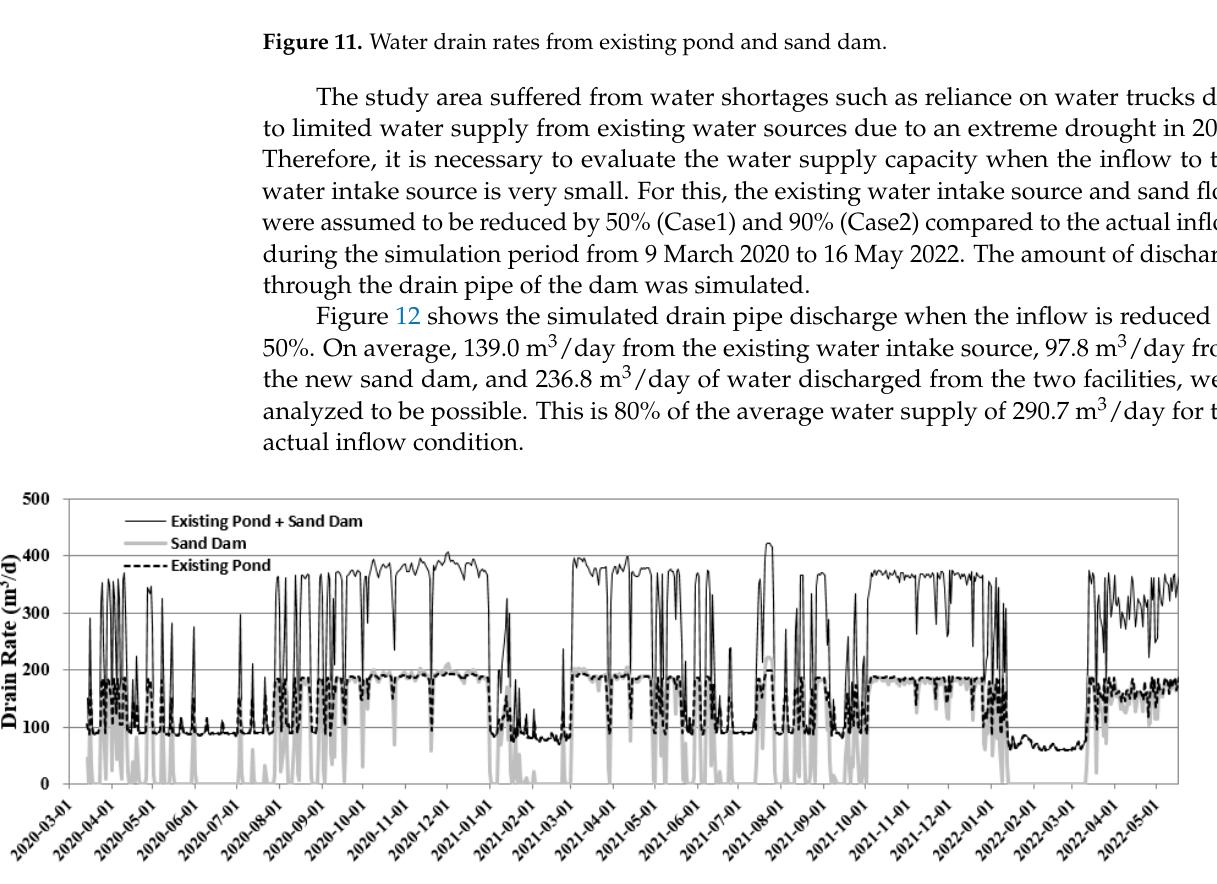
Figure 11. Water drain rates from existing pond and sand dam.